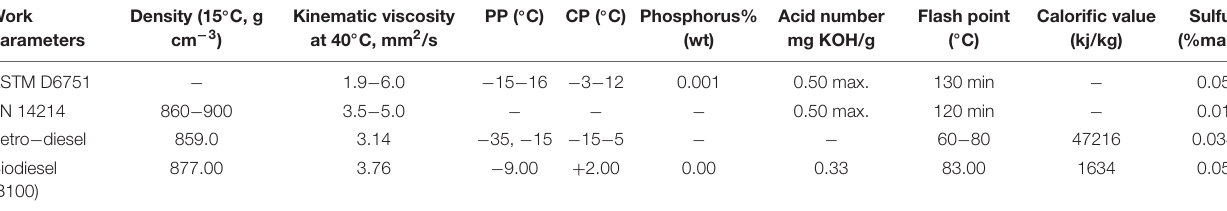
FIGURE 8 | (A,B) Effect of Reaction Time on Esterification and Transesterification Steps. TABLE 1 | Comparative Fuel Properties Analysis of Energy Crop Cocklebur Methyl Esters